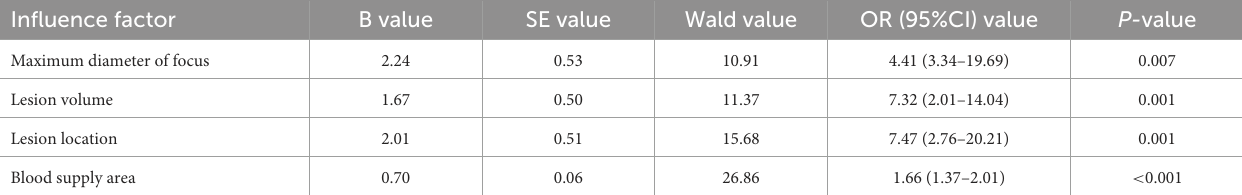
TABLE 2 Multivariate logistic regression analysis of ICA complicated with intracranial hemorrhage. Influence